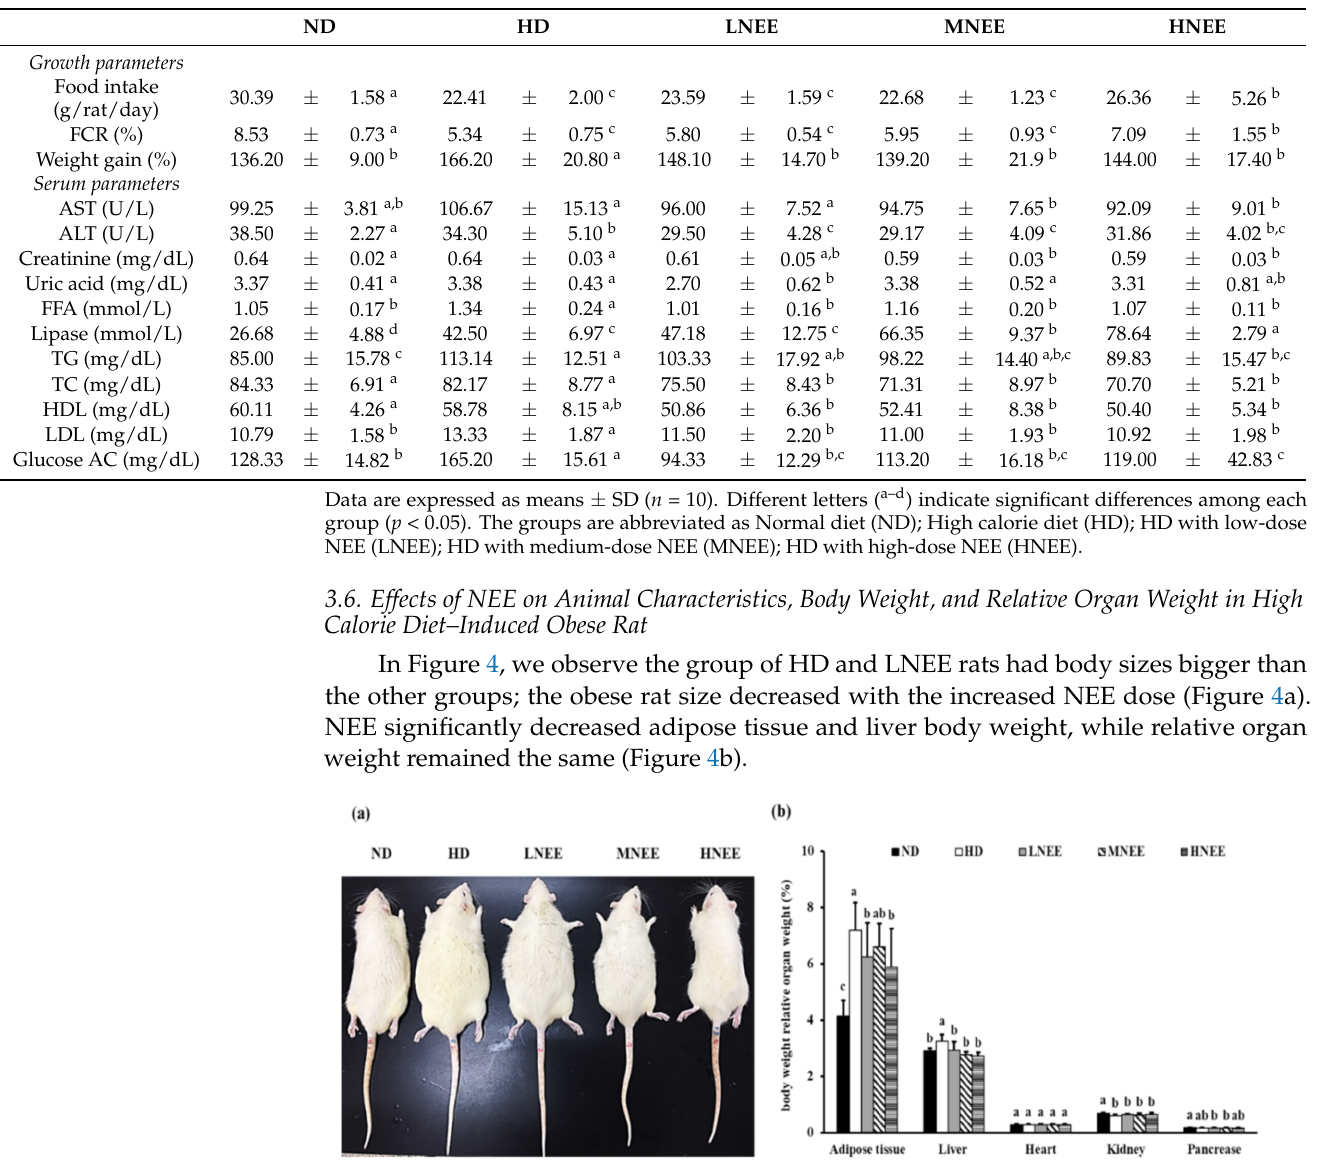
Figure 4. Effects of NEE on animal characteristics and bodyweight-related organ weight in high calorie diet–induced obese rats. Obesity in rats as generated by a high-calorie diet ( a ) and the relationship between body weight and organ weight ( b ). The significance of the organ disparity was determined using Duncan’s test. The means and standard deviations ( n = 10) are the data. Statistically significant differences between the organs are denoted by different letters (a–c) ( p < 0.05). The group names are defined in Table 2